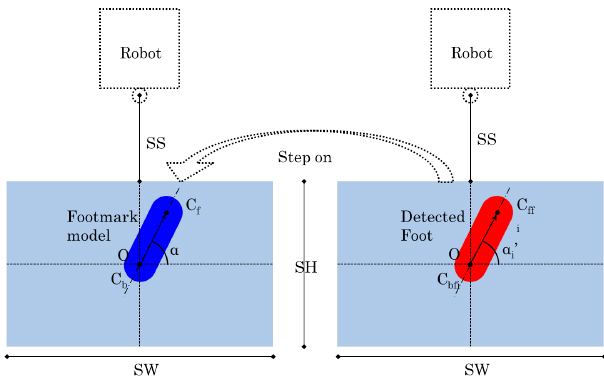
Fig. 17. Foot Detection Experiment in Forward Direction